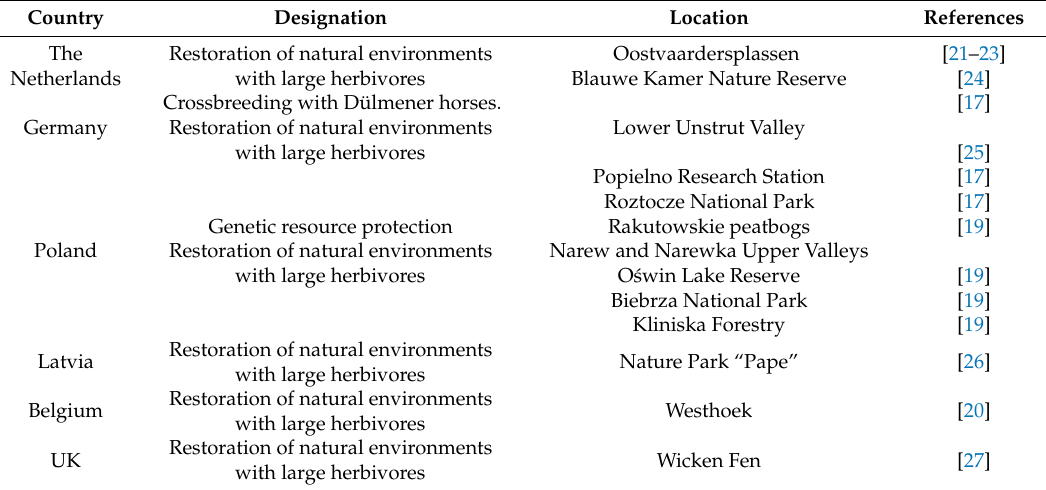
Table 1. Konik polski horses in European environmental